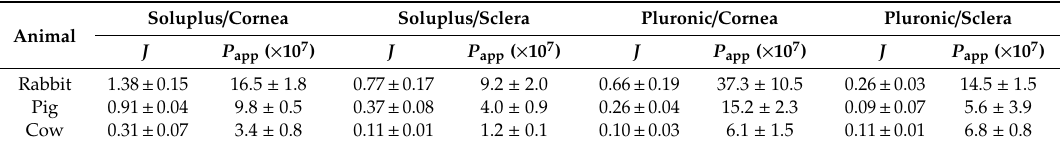
Table 5. Flux ( J , µ g / (cm 2 · h)) and permeability coe ffi cient ( P app , cm / s) in rabbit, pig, and cow cornea and sclera for PG formulated in Soluplus and Pluronic micelles ( n = 4). The total polymer concentration was 20% w / w in all cases ( n =